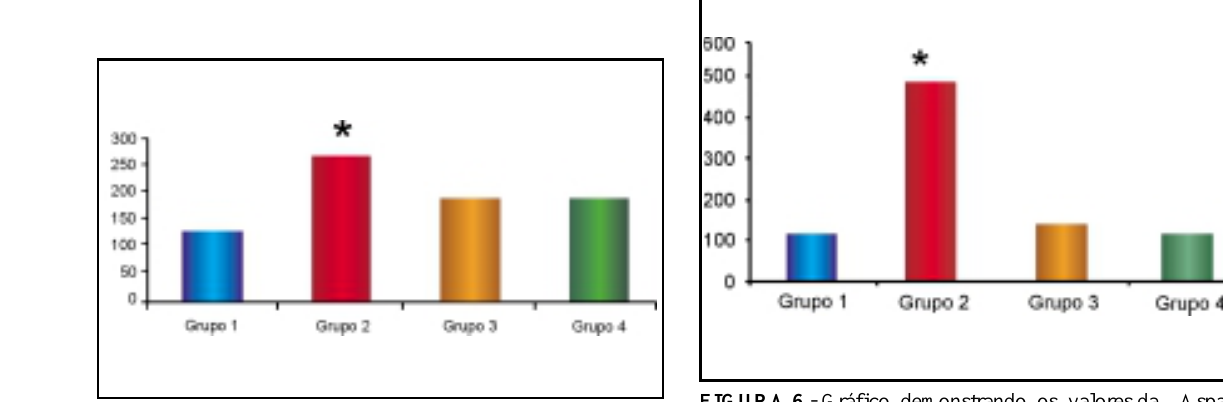
FIGURA 3 - Gráfico informando a medida da Fosfatase Alcalina (FA - U/L), (* = p < 0.05).